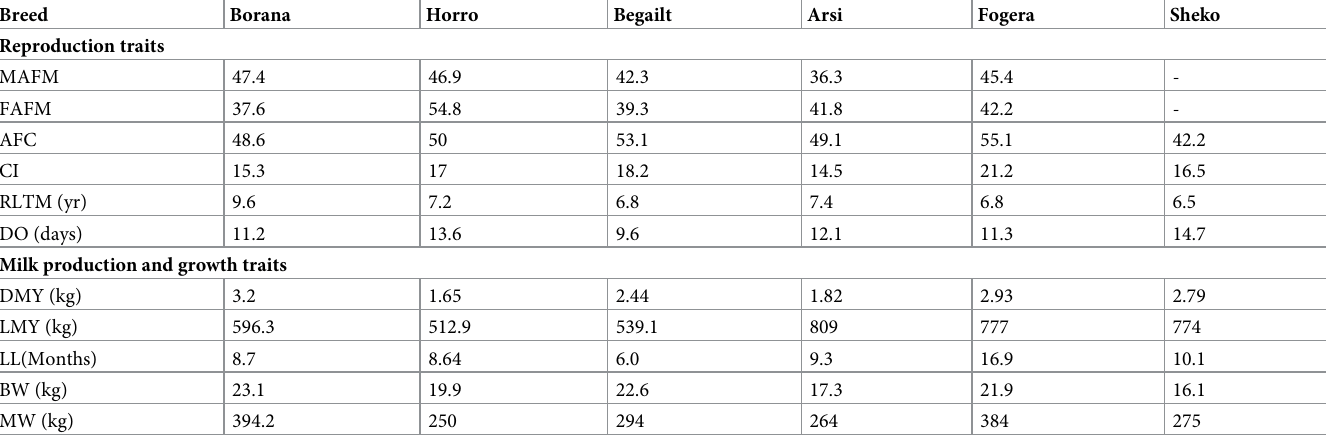
Table 4. Average reproduction and production performances of Boran cattle as compared to other Ethiopian cattle breeds. Breed